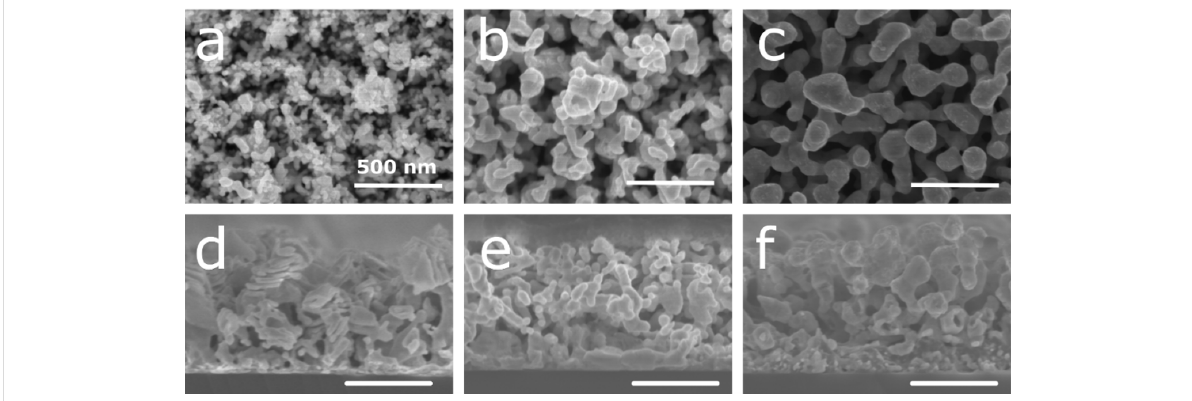
Figure 3: (a–c) Plan view and (d–f) cross-section SEM images of the Ag–Al alloy thin film dealloyed for 60 min in HCl solution at 1 wt % with an initial composition of (a, d) 18, (b, e) 30, and (c, f) 36 atom % of Ag. Scale bar: 500 nm.